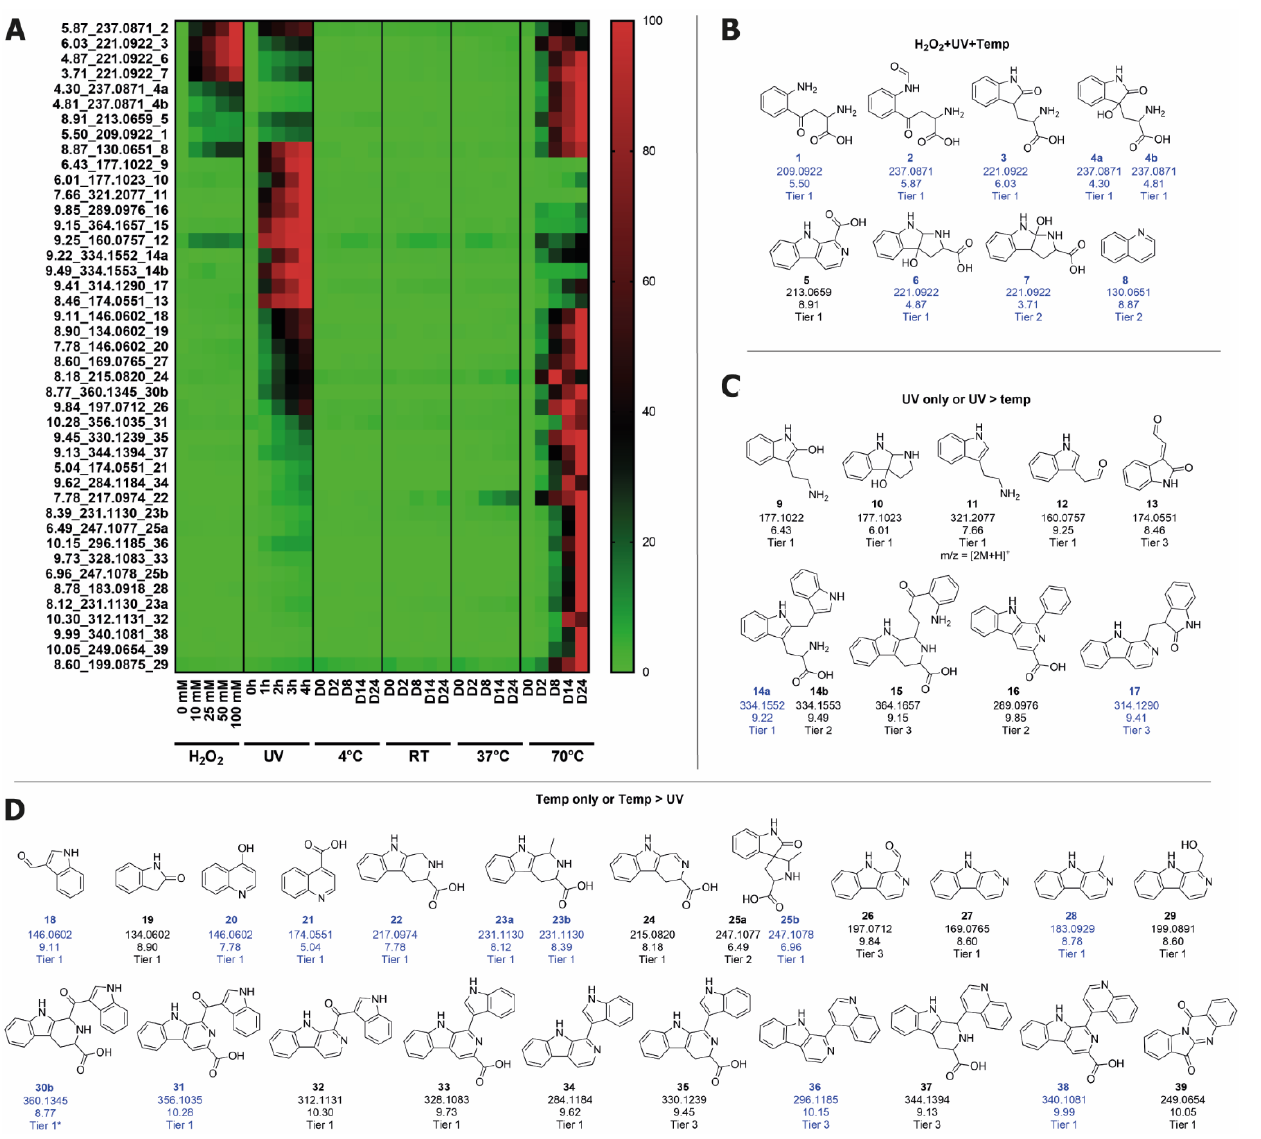
Figure 4. Tier 1–3 features in the aqueous Trp samples which were significantly modulated in at least one of the stress conditions. ( A ) Normalized abundance profiles of each feature (rt_m/z_structure number), presented in a heatmap. Green represents the lowest abundance and red the highest abundance for each feature independently. Structures for features that were increased ( B ) in all stress conditions, ( C ) in UV only or UV > 70 ◦ C conditions, and ( D ) in 70 ◦ C only or 70 ◦ C > UV conditions. All m/z represent [M+H] + unless specified otherwise (shown with structures). Features that are also present in the 37 ◦ C feed experiment (Table S1) have the compound number and feature data displayed in